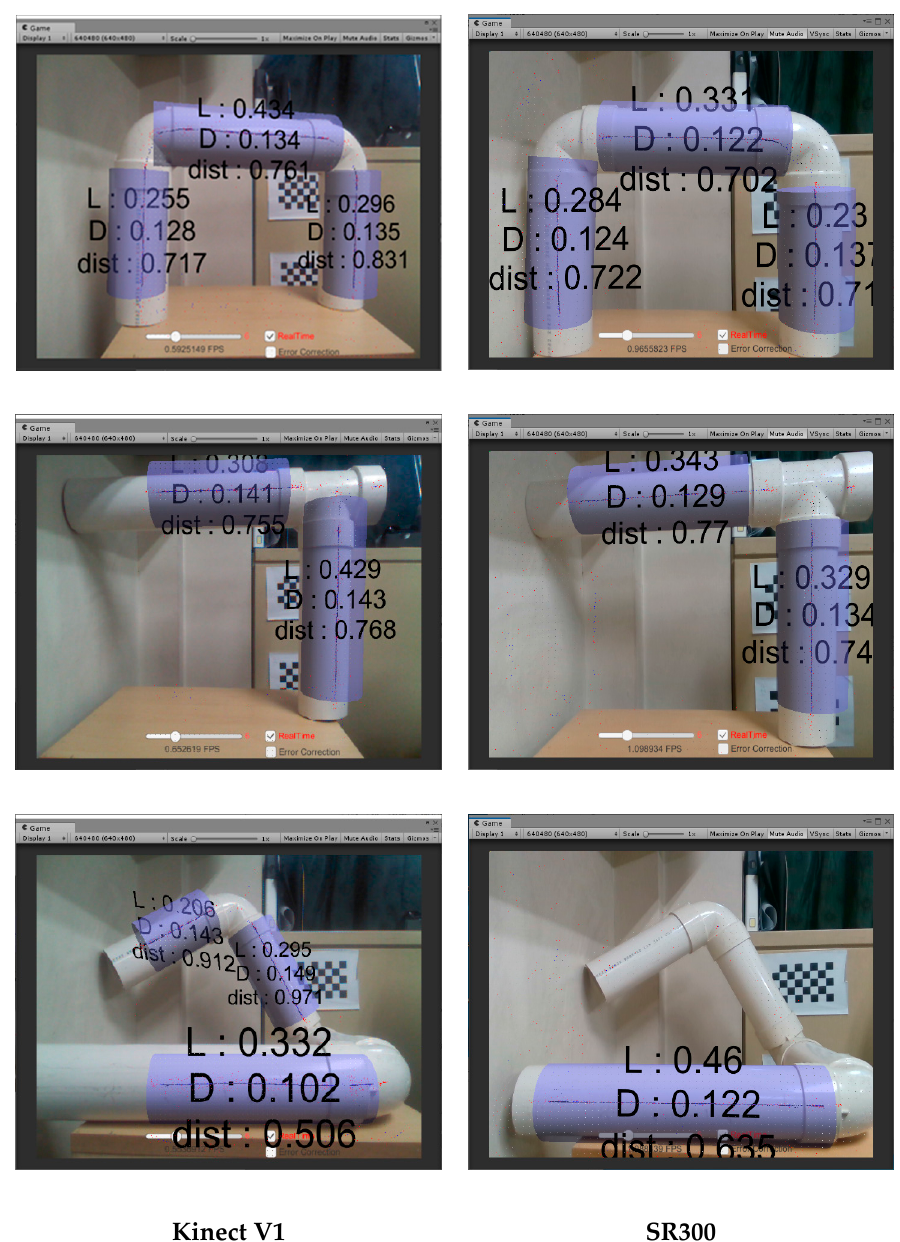
Figure 22. Real-time matching results with six cores and six frames; 𝛜 = 50. (m)